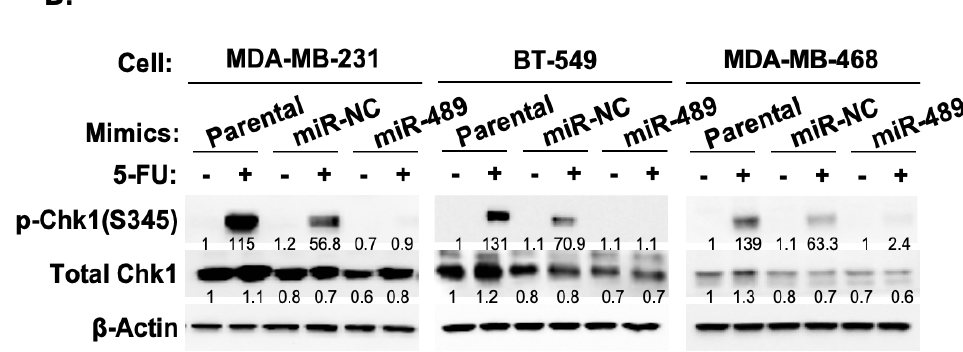
Figure 1. miR-489 mediates anti-proliferative and DNA damaging blocking functions of ARRDC3 in triple-negative breast cancer (TNBC). ( A ) MDA-MB-231 cells transfected with indicated miRNA mimics were incubated for 24, 48 and 96 hrs. Proliferation of these cells was measured by MTT assay. Data are represented as mean ± SD ( n = 3). ** p < 0.01 compared with the control. ( B ) Cell migration assay of MDA-MB-231 cells with indicated miRNA mimics. Column, mean from three independent experiments; bars, SD. The statistical analysis was done using Student’s t test. * p < 0.05, ** p < 0.01. ( C ) MDA-MB-231 cells transfected with miR-negative control (miR-NC) and miR-489 mimics were incubated for 48 h, followed by with or without treatment of 5 µ M 5-FU for 72 hrs. Proliferation of these cells was measured by MTT assay. Column, mean from three independent experiments; bars, SD. * p < 0.05; compared with the control. ( D ) Western blotting analysis p-Chk1 (S345), total Chk1 or β -Actin from lysates of MDA-MB-231, MDA-MB-468 and BT-549 TNBC cells transfected with or without miR-NC or miR-489, followed by with or without treatment of 5 µ M 5-FU for 48 h. β -actin was used as loading control. Densitometric analysis was performed using Image J. The number shown underneath the band image represents the fold change compared with control. Representative results were obtained from three independent experiments. More details of western bolts, please view at the supplementary materials.